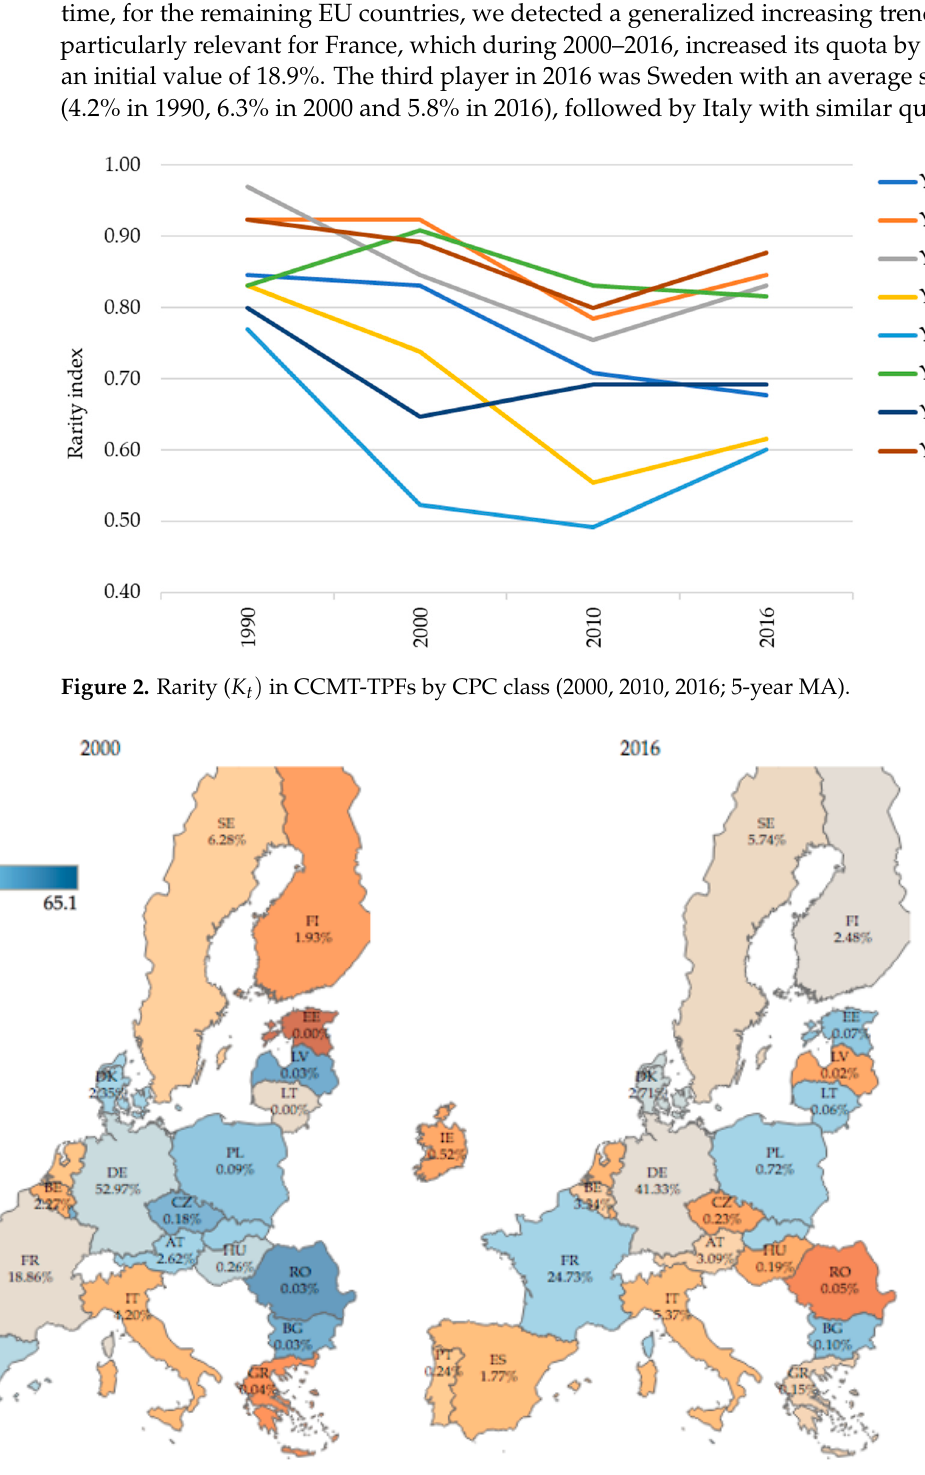
Figure 3. Shares (text) and RTA (color range) in CCMT-TPFs in Europe (2000 and 2016; 5-year MA).